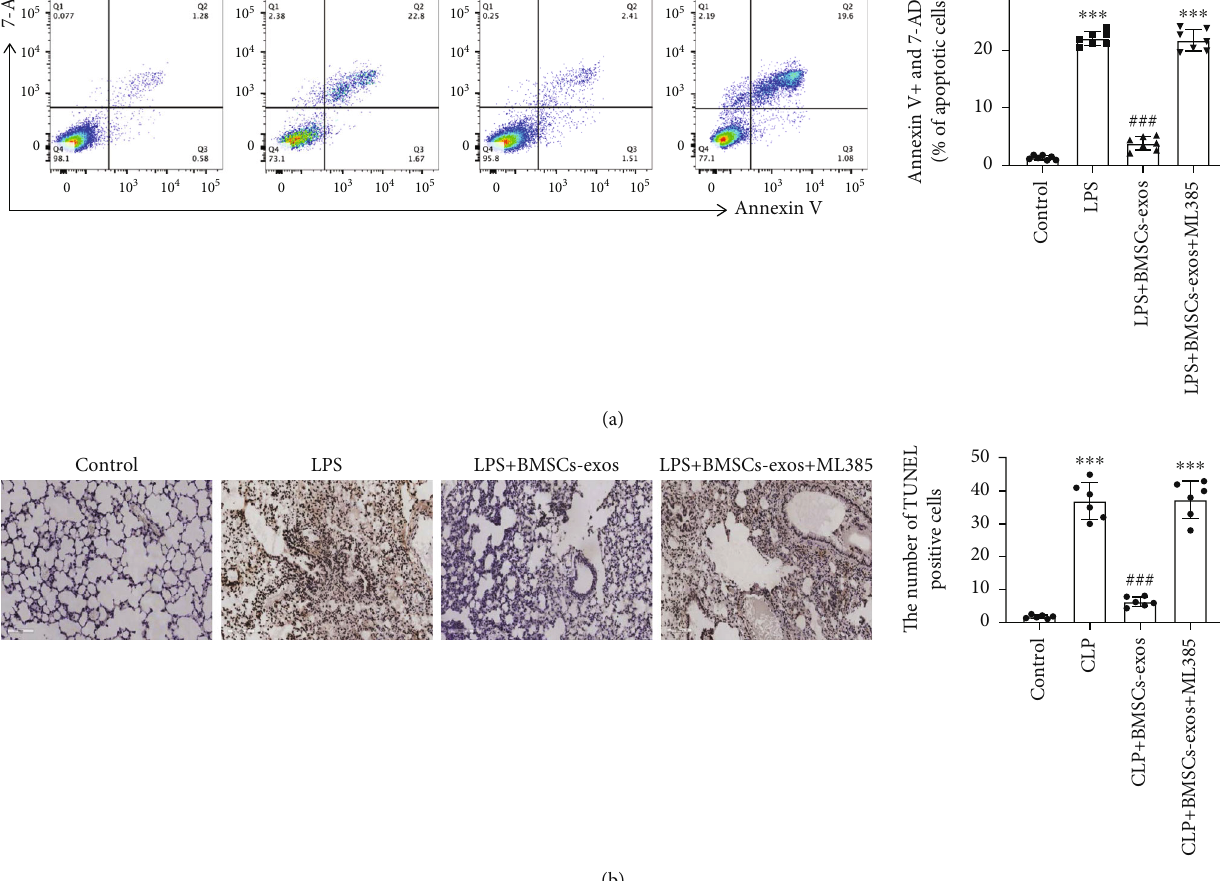
Figure 4: BMSC-exos alleviated sepsis-treated AECII apoptosis via activating the Nrf2 pathway in vivo and in vitro . AECIIs were pretreated with ML385 (20 μ M) for 30 min, followed by LPS (25 μ g/ml) for 1 hour, and subsequently cocultured with BMSC-exos (100 μ g/ml) for 48 hours. (a) The frequency of double Annexin V- and 7-AAD-positive AECIIs was characterized by fl ow cytometry. The mice were intraperitoneally injected with ML385 (30 mg/kg) 2 hours before CLP surgery and BMSC-exosomes (300 μ g/mouse) 1 hour before CLP surgery. (b) TUNEL staining (brown) was detected in the lung sections of all the treated mice. Data are represented as the mean ± SD , n = 6 per group. NS: nonsigni fi cance; ∗∗∗ P < 0 : 001 vs. the control group; ### P < 0 : 001 vs. the LPS group or CLP